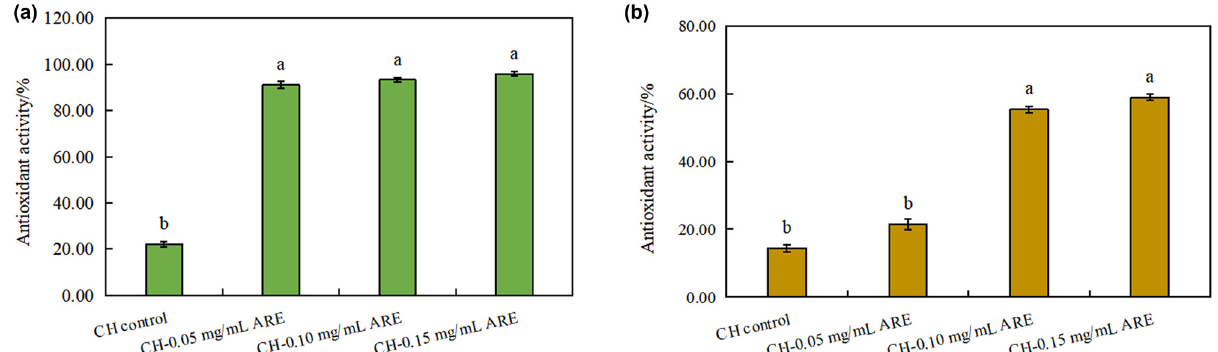
Figure 2: DPPH radical scavenging activity ( a ) and ABTS + radical scavenging test ( b ) of CH/ARE composite fi lms. Di ff erent letters are used to indicate the signi fi cance of the di ff erence between the composite fi lm samples in the same column ( p < 0.05 )